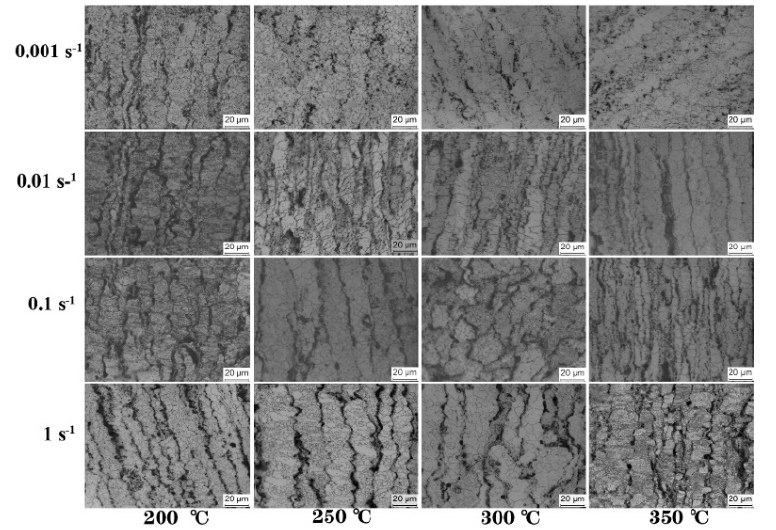
Figure 4. Optical microscope images of 0.05 wt.% ND / ZK60 composite compressed at di ff erent deformation temperatures and strain rates.